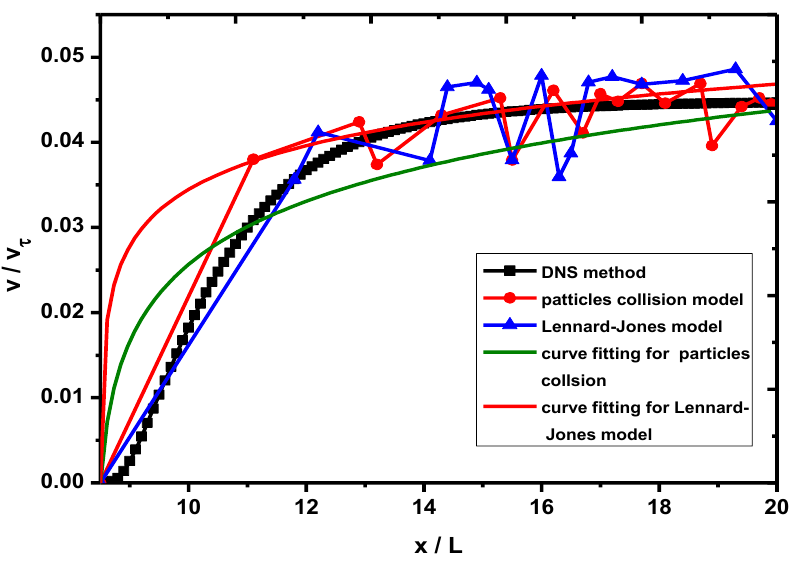
Fig. 13. the velocity variation and fitting curve along the horizontal centerline